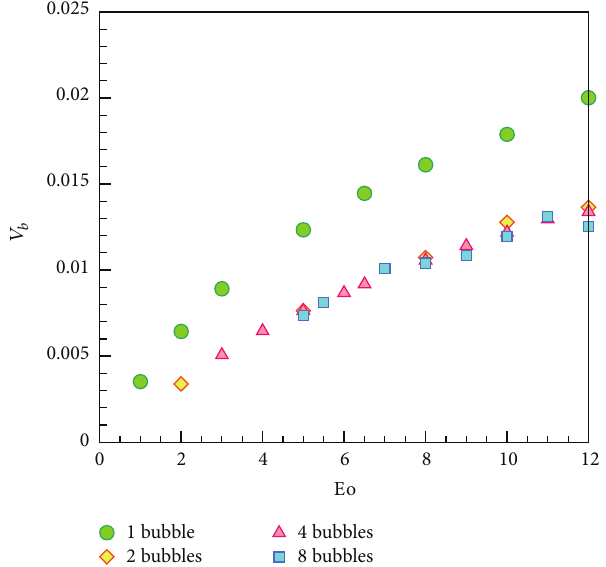
Figure15:TheterminalrisingvelocityfordifferentEotvosnumbers. The bubbles are placed in a horizontal arrangement and the initial distance is 2.5 𝑅